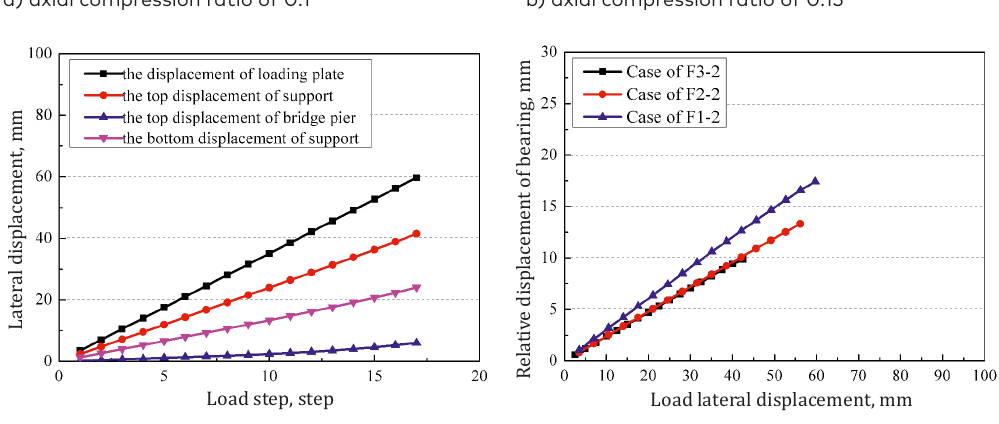
a) axial compression ratio of